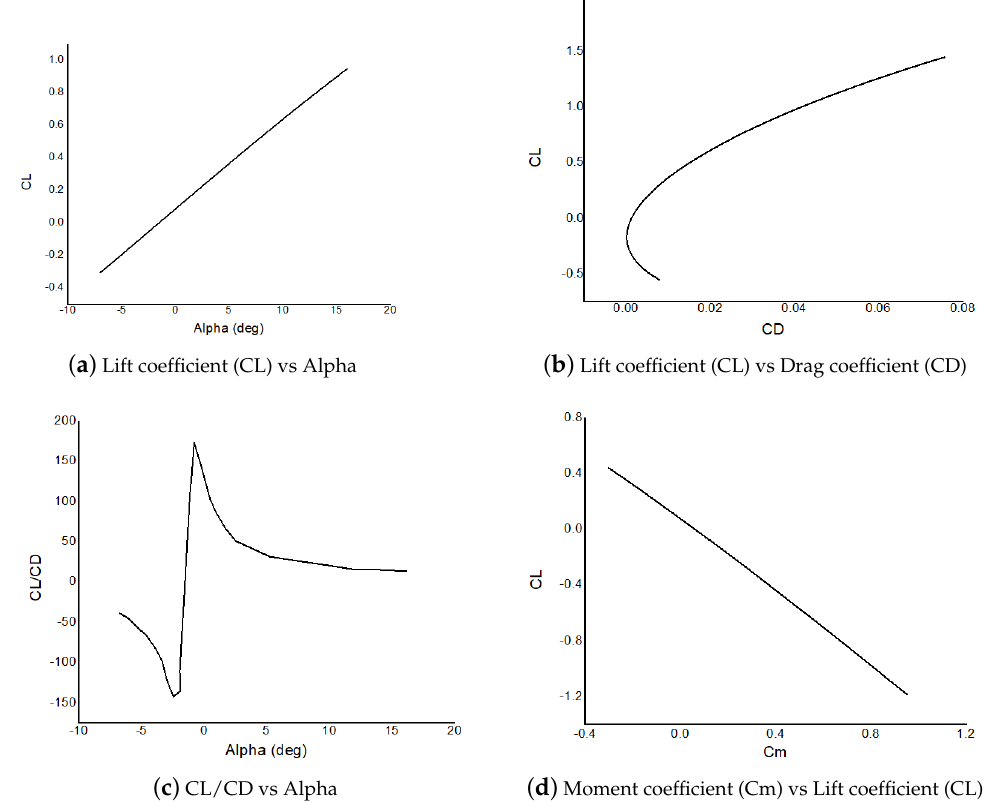
Figure 12. Aicraft analysis using XFLR software ( a ) Variation of lift coefficient (CL) with angle of attack obtained using XFLR. ( b ) Variation of lift coefficient vs. drag coefficient obtained using XFLR. ( c ) Variation of CL/CD with angle of attack. ( d ) Variation of moment coefficient vs. lift coefficient. The trends are similar to that of the Boeing 737 commercial